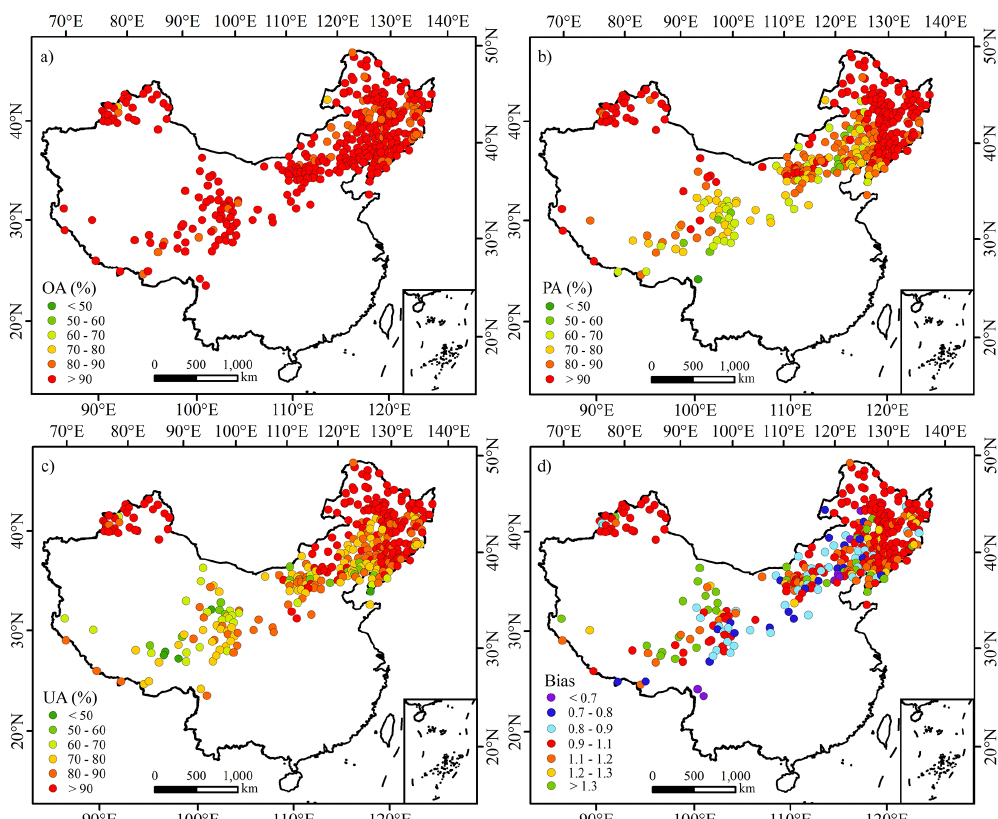
Figure 10. Accuracies of the CGF-MODIS SCE dataset at each CMA station: (a) OA, (b) PA, (c) UA, and (d) Bias.